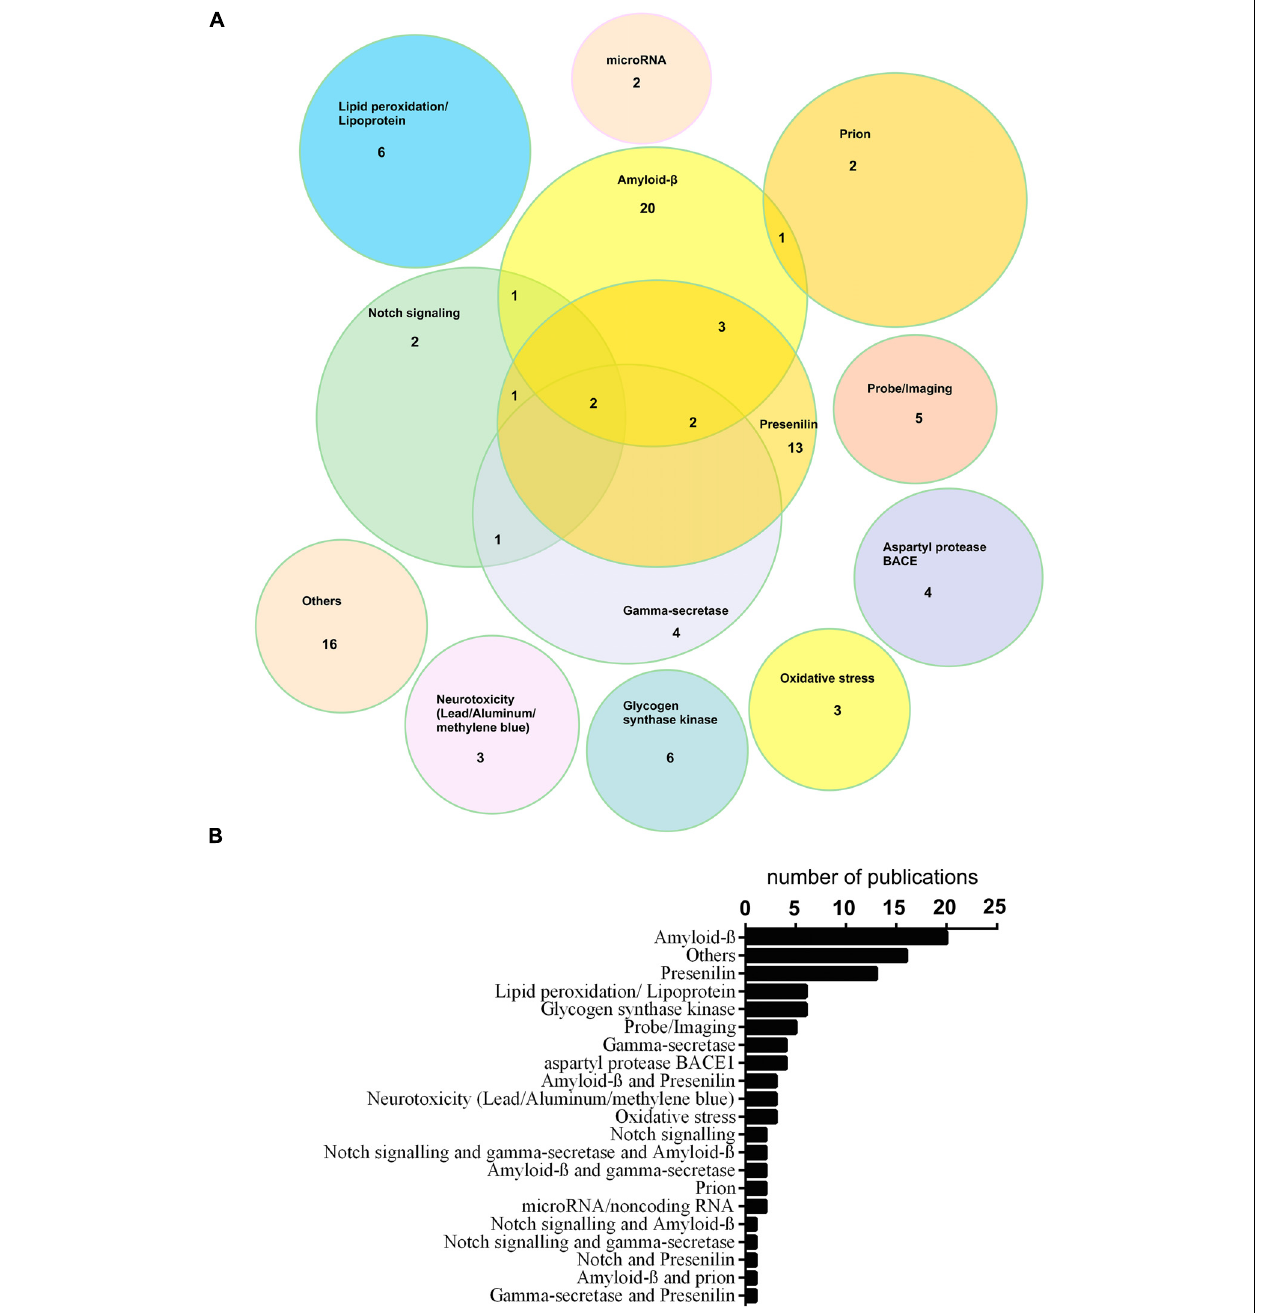
language interprets these to logical concepts and extracts functional relationships between proteins, small molecules, and cellular processes (Nikitin etal., 2003b; Novichkova etal., 2003a). 119 publications were found. Abstracts of these publications were studied and review papers were removed such that 98 papers remained. (A) Venn diagram and (B) bar graph showing numbers of research papers in different areas. A concentration of research on Amyloid β and Presenilin function is